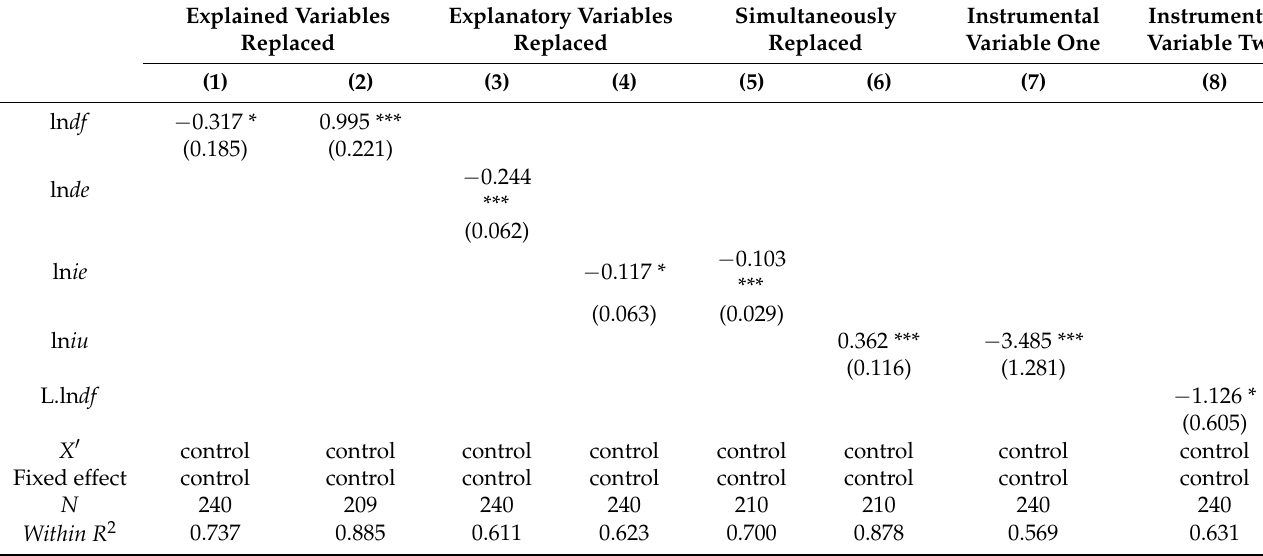
Table 5. The robustness and endogenous results of digital finance affecting green